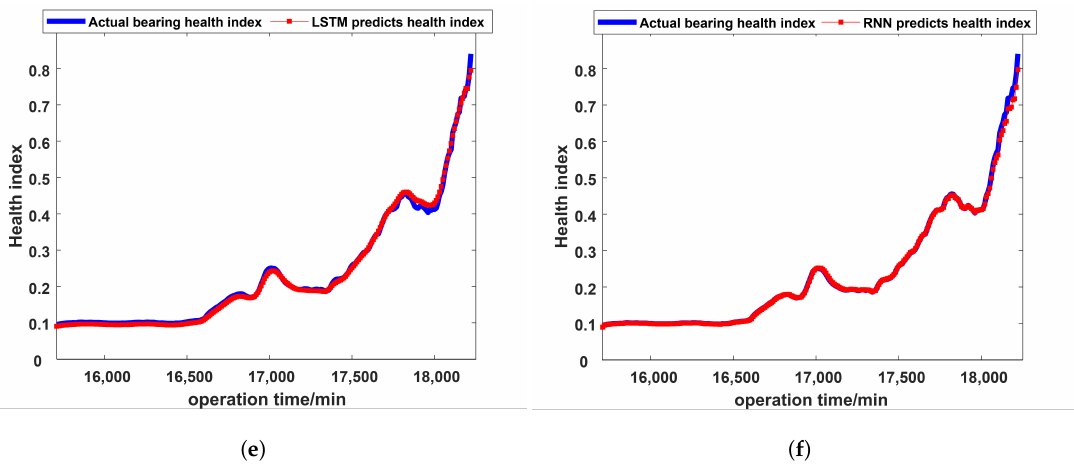
Figure 11. The results of different fault prognosis methods. ( a ) The fault prognosis results of the CDBN. ( b ) The fault prognosis results of the BPNN. ( c ) The fault prognosis results of the SVR. ( d ) The fault prognosis results of the DBN. ( e ) The fault prognosis results of the LSTM. ( f ) The fault prognosis results of the RNN.